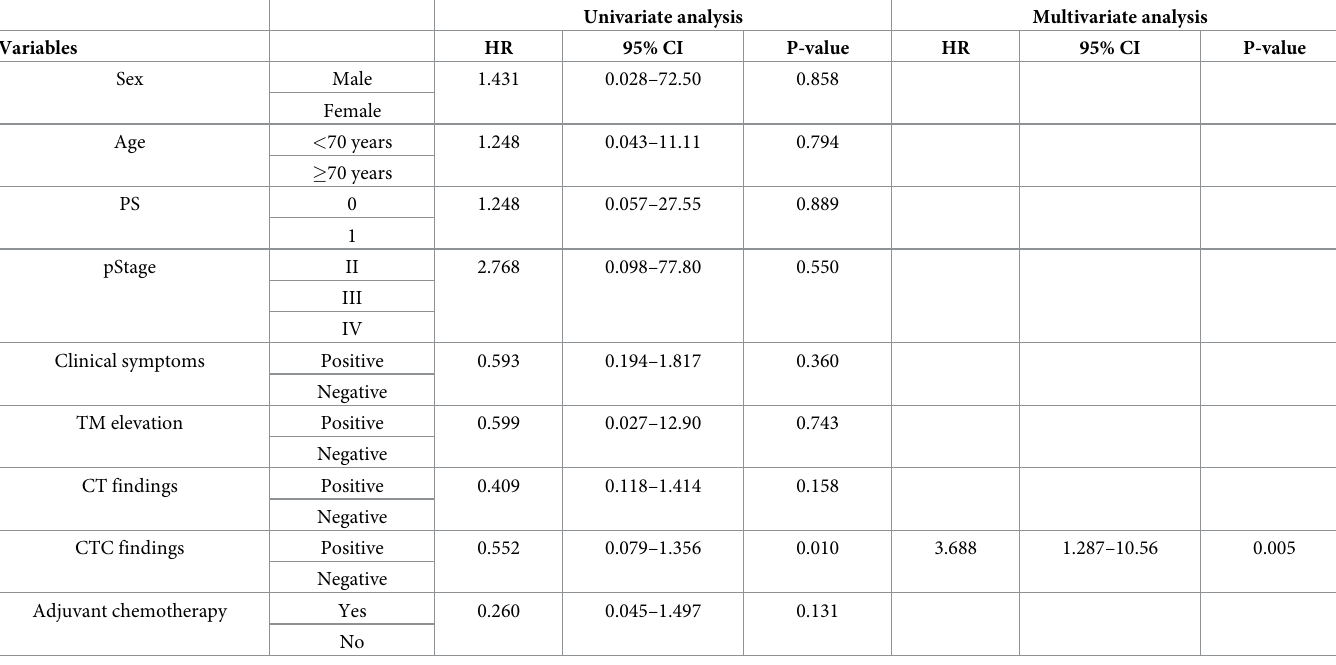
Table 4. Univariate and multivariate Cox proportional hazards analyses of the clinicopathological factors associated with survival after